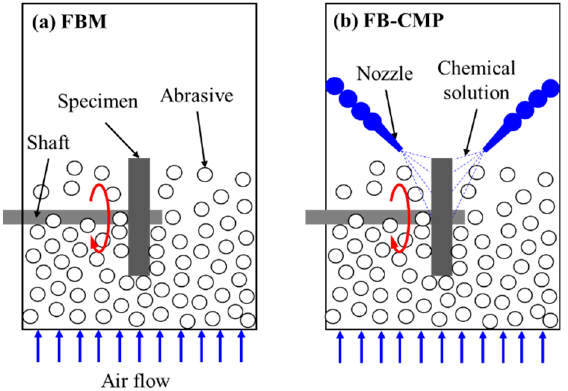
Figure 1. Conceptual diagram for the comparison of fluidized bed machining (FBM) and fluidized bed chemical mechanical polishing (FB-CMP).